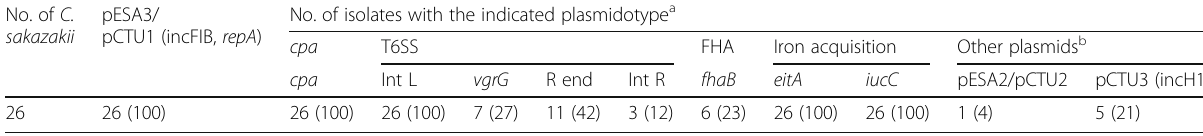
Table 6 Prevalence and distribution of pESA3 alleles associated with the virulence plasmid and pESA2/pCTU3 plasmids harbored by 26 spice-associated C. sakazakii